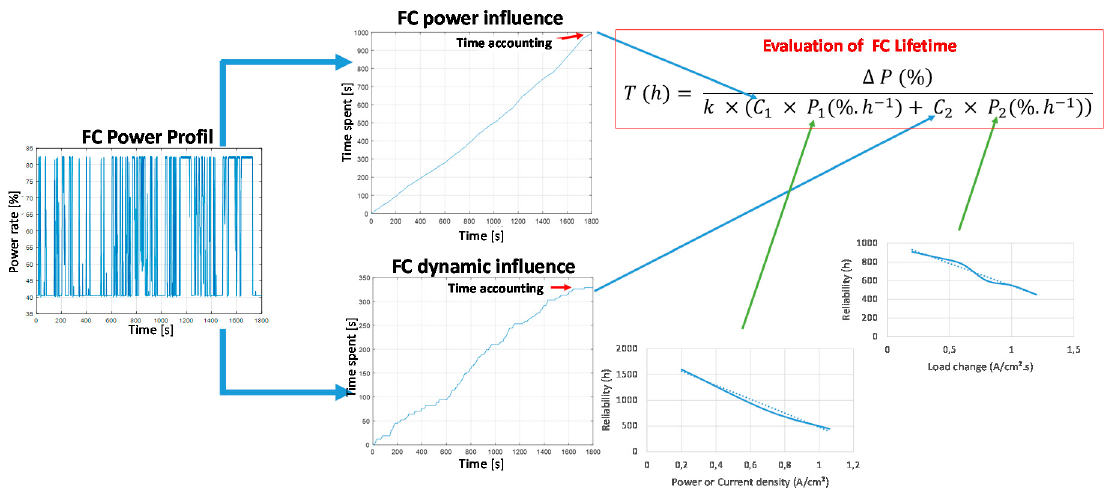
Figure 11. Fuel Cell reliability assessment